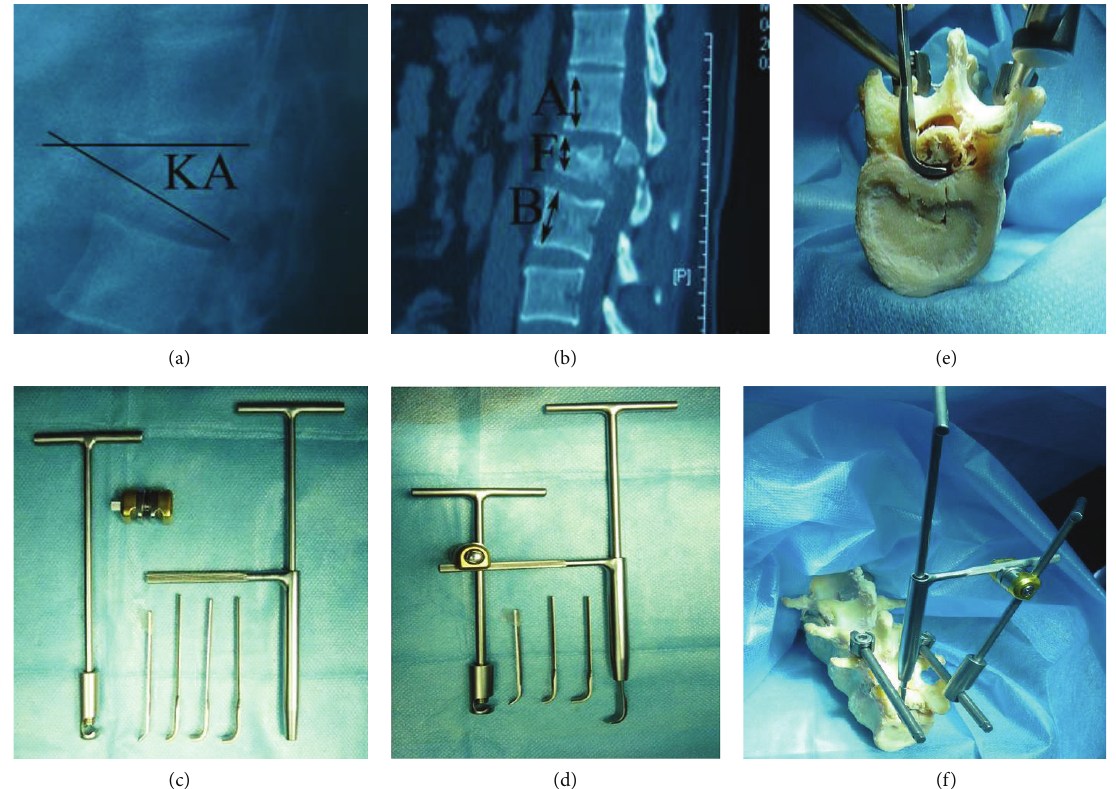
Figure 1: (a)-(b) The diagram of kyphotic deformity and vertebral body height calculated in current study. Vertebral body height = 2𝐹/(𝐴 + 𝐵) ∗ 100 . (c)-(d) The physical map of a novel custom-designed repositor (RRBF). (e)-(f) The usage and preclinical application of